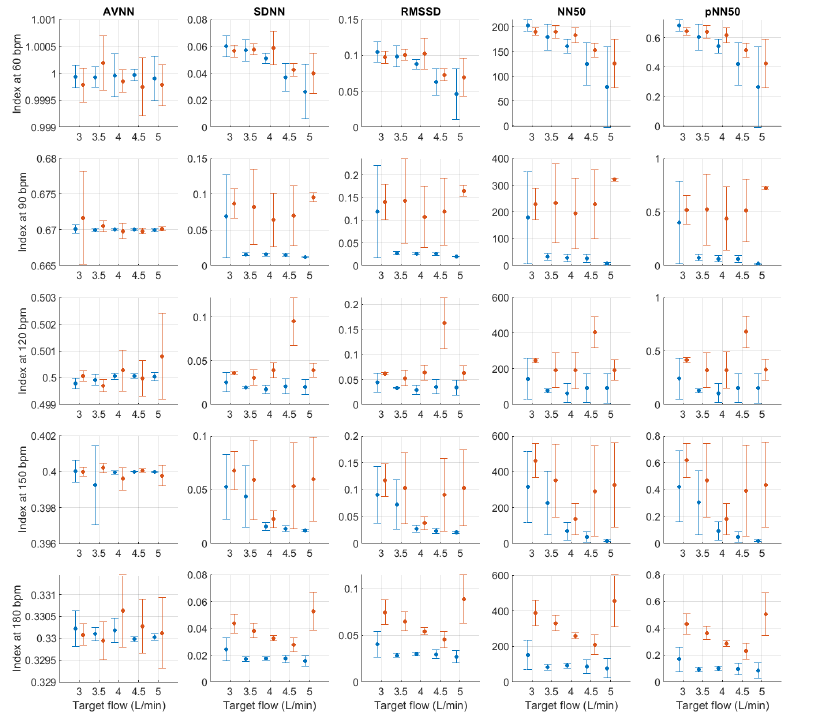
Figure A5. Mean and standard deviation of time-domain indices extracted from pulse rate variability under different stroke rates (SR) and target flows (TF, TF above 2.5 L/min) conditions, and measured from the radial (blue) and deep palmar arch (orange) phantoms.